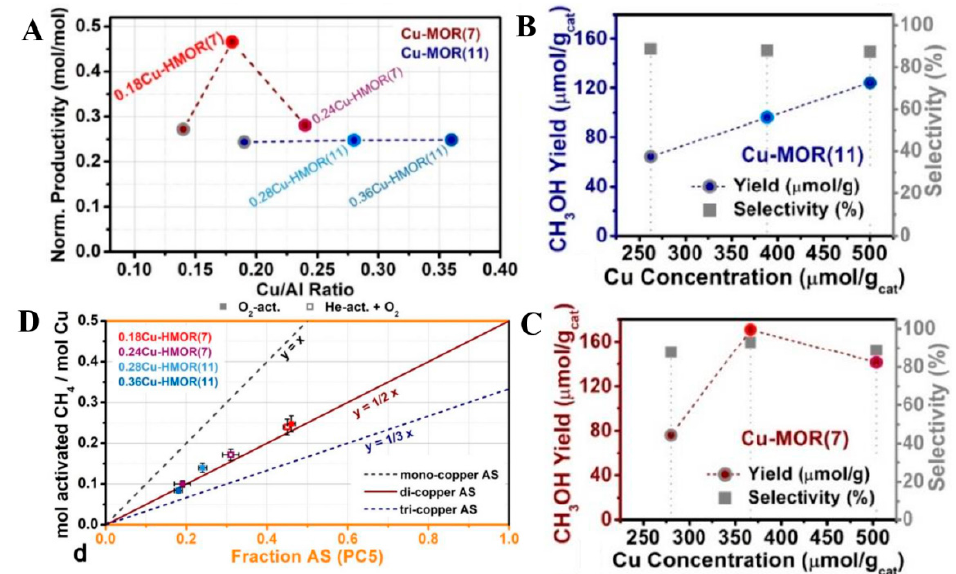
Figure 15. ( A ) Normalized productivity (mol CH 3 OH/mol Cu) as a function of the Cu:Al ratio, comparing the Cu/MOR(7) and Cu/MOR(11) series. ( B , C ) CH 3 OH yield and selectivity as a function of Cu concentration ( µ mol Cu/g cat. ) for Cu-MOR materials with Si:Al = 7 (B, Cu/MOR(7) series) and Si:Al = 11 (C, Cu/MOR(11) series). ( D ) Quantitative correlation between the normalized productivity evaluated at the HERFD XANES testing conditions and the fraction of LT redox-inert fw-Cu II from linear combination fit analysis (O 2 -activation: full colored symbols; He activation+O 2 : empty colored symbols). All the experimentally determined values match the ideal trend line for stoichiometric conversion over a dicopper active site, reported as a full dark red line. Reprinted with permission from [33]. Copyright 2018 American Chemical